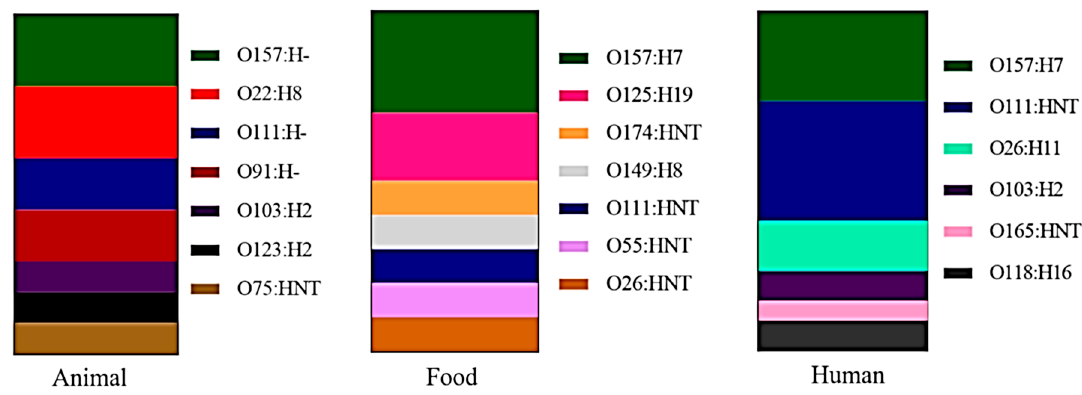
Figure 2. Main serotypes present in each assessed group reported from 2000 to 2018.